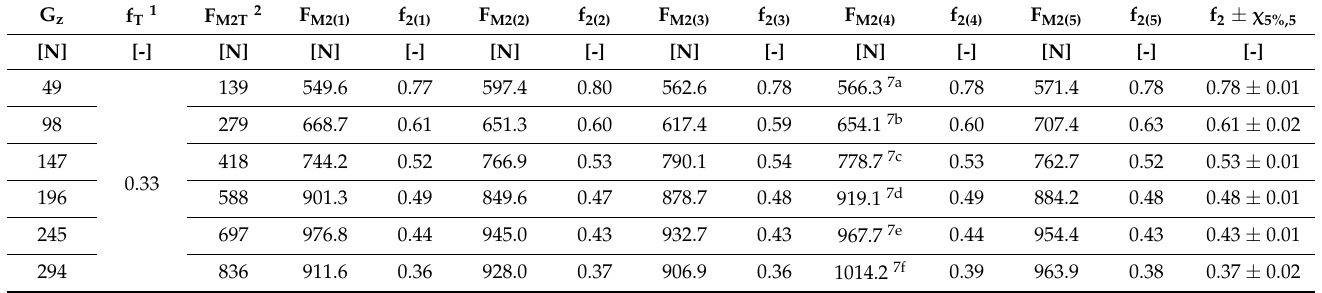
Table 7. Tensile force F M2(i) [N], φ 6 mm rope, V-shape groove, dihedral angle 35 deg, clean condition.